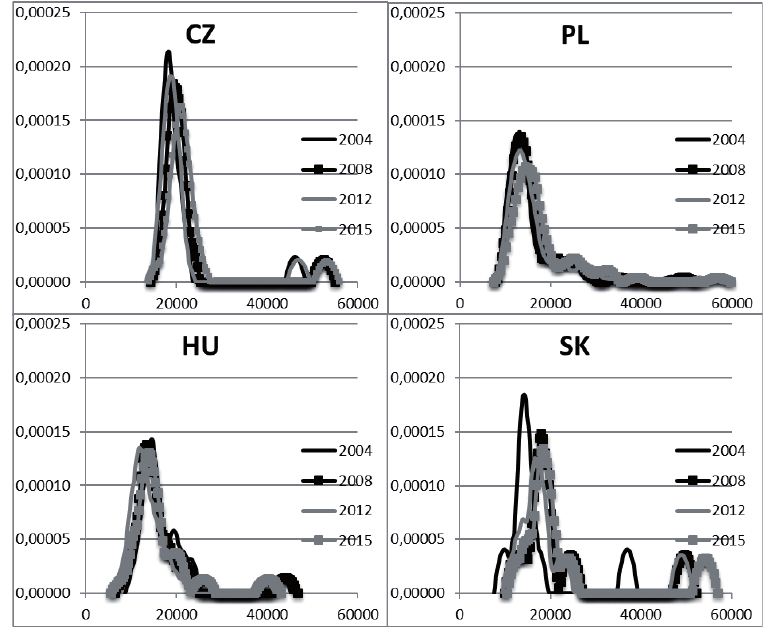
Fig. 3 – Regional income density functions in the V4 countries in selected years (x-axis – income measured in thousands of EUR in PPS at 2015 prices; y-axis – density). Source: Own calculations based on Eurostat database (access: